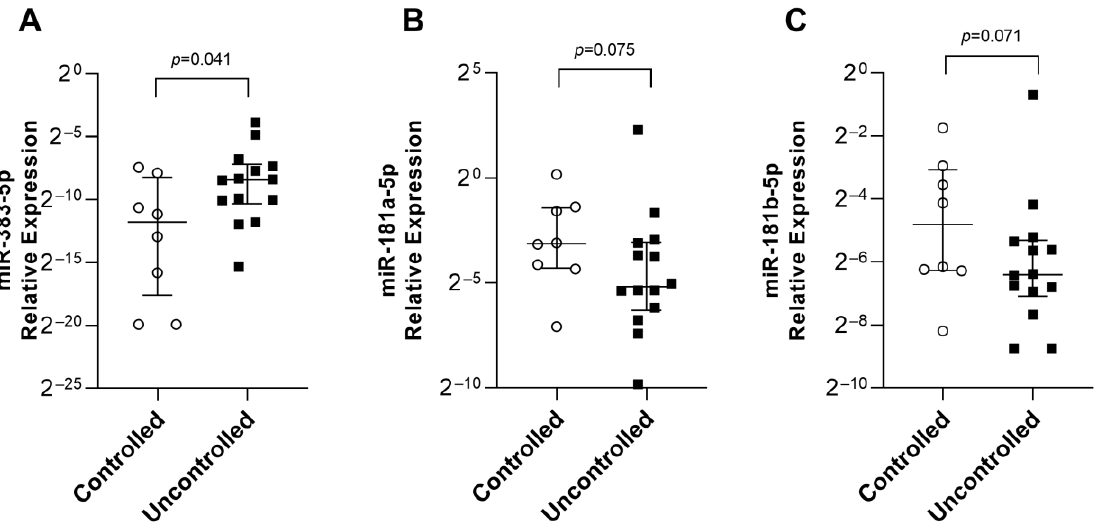
Figure 3. miRNAs differentially expressed between the controlled and uncontrolled groups according to their relative expression. ( A ) miR-383-5p. ( B ) miR-181a-5p. ( C ) miR-181b-5p. On the y -axis, the relative expression is scaled by Log2. On the x -axis are the controlled and uncontrolled groups. Black squares are uncontrolled tumors, and white dots are controlled tumors. Table 4. Median miRNA qPCR relative expression (minimum and maximum values) in each group.